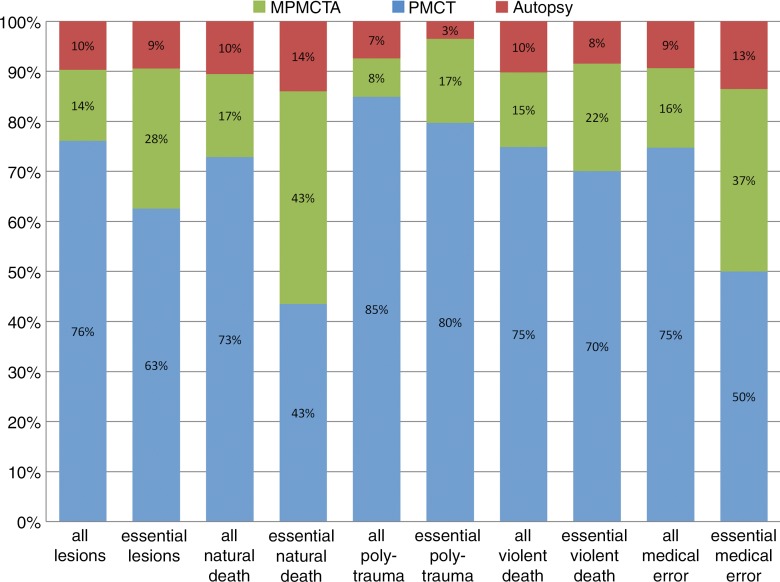
Graph of additional postmortem findings. (a) Additional findings obtained by using imaging with autopsy. Autopsy findings as a percentage of all findings are in red. Additional findings not observed at autopsy but identified at postmortem CT are in blue. Green indicates findings undiscovered at both autopsy and postmortem CT but detected at postmortem CT angiography. There is a relatively high effect of postmortem CT in polytrauma evaluation and of postmortem CT angiography in medical errors and natural death. (b) Additional findings obtained by using angiography with postmortem CT, and then by performing an autopsy. Postmortem CT findings as a percentage of all findings are in blue. Additional findings detected by using postmortem CT angiography are in green. Finally, findings only detected at autopsy are in red. Notice the relatively high effect of autopsy in medical errors and natural death, and the low effect in evaluation of polytrauma.